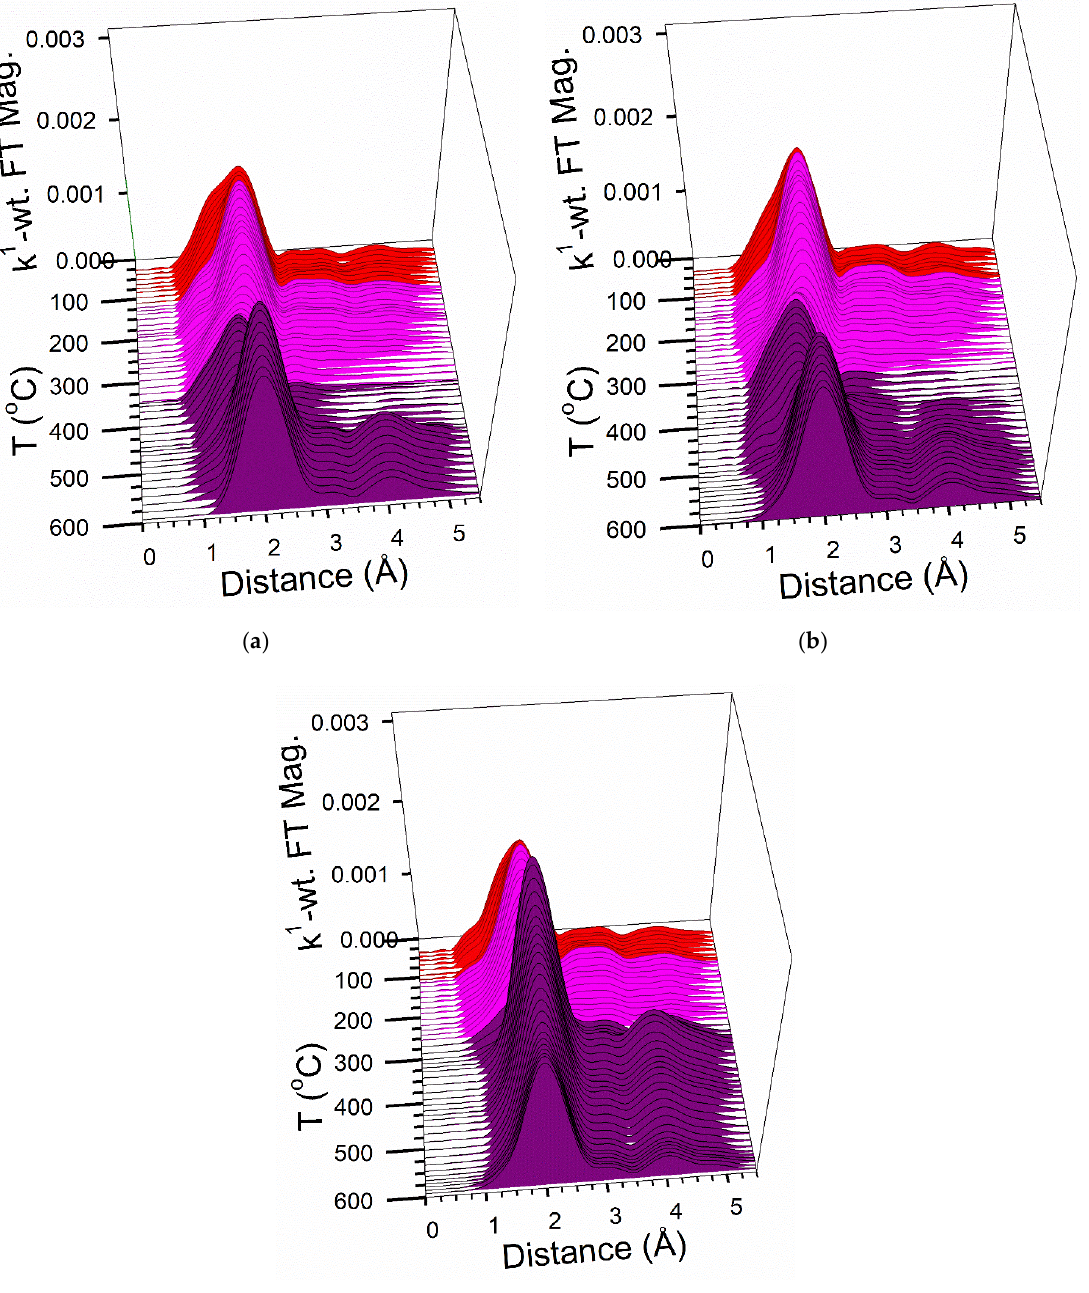
Figure 14. TPR-EXAFS profiles of ( a ) calcined 12% Co/SiO 2 from cobalt chloride, ( b ) uncalcined 12% Co/SiO 2 from cobalt chloride, and ( c ) uncalcined 0.5% Pt-12% Co/SiO 2 from cobalt chloride.